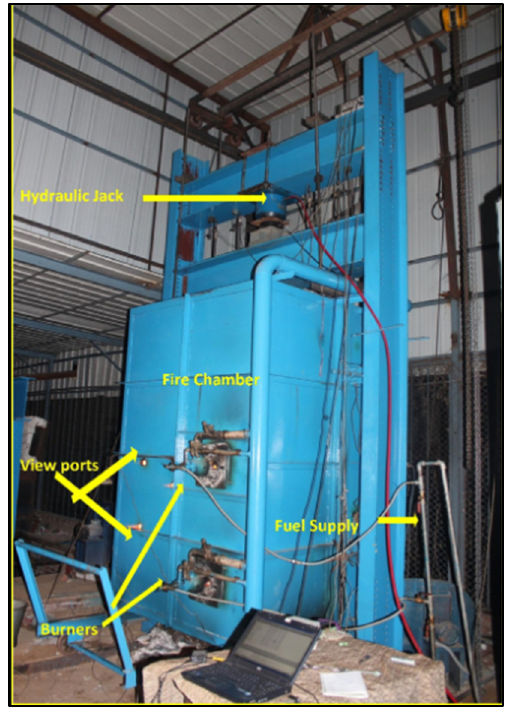
Figure 13. Confined ‐ concrete ‐ column fire ‐ resistance test. Sarker et al. conducted a fire durability test on steel-reinforced fly-ash